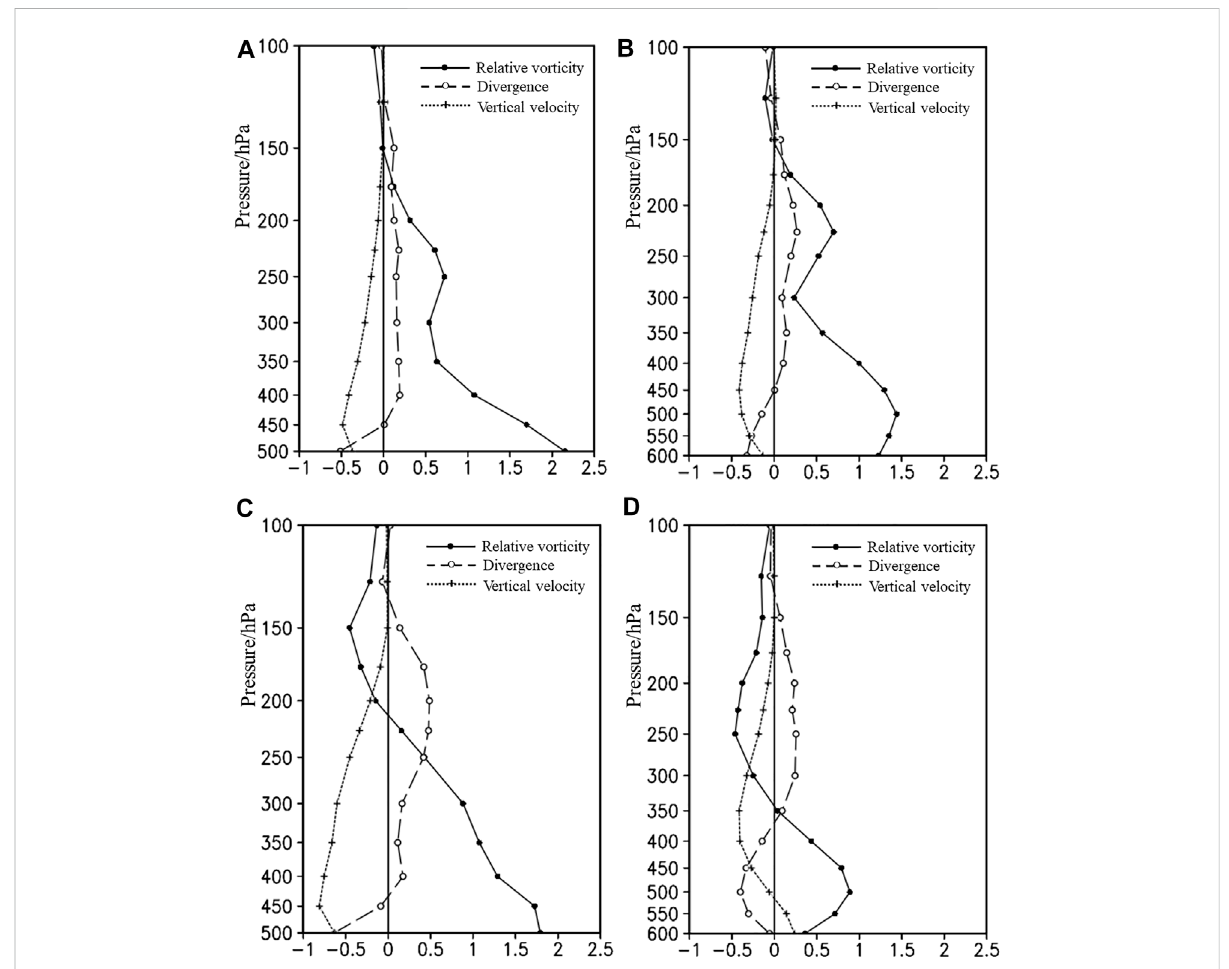
FIGURE 4 The vertical distribution of relative vorticity (solid, Unit: 10 – 4 s − 1 ), divergence (hollow, Unit: 10 – 4 s − 1 ) of vortex center and vertical velocity (cross, Unit: Pa · s − 1 ) at plateau stage and moving-out plateau stage in Case 2012 (A,B) and Case 2013 (C,D)